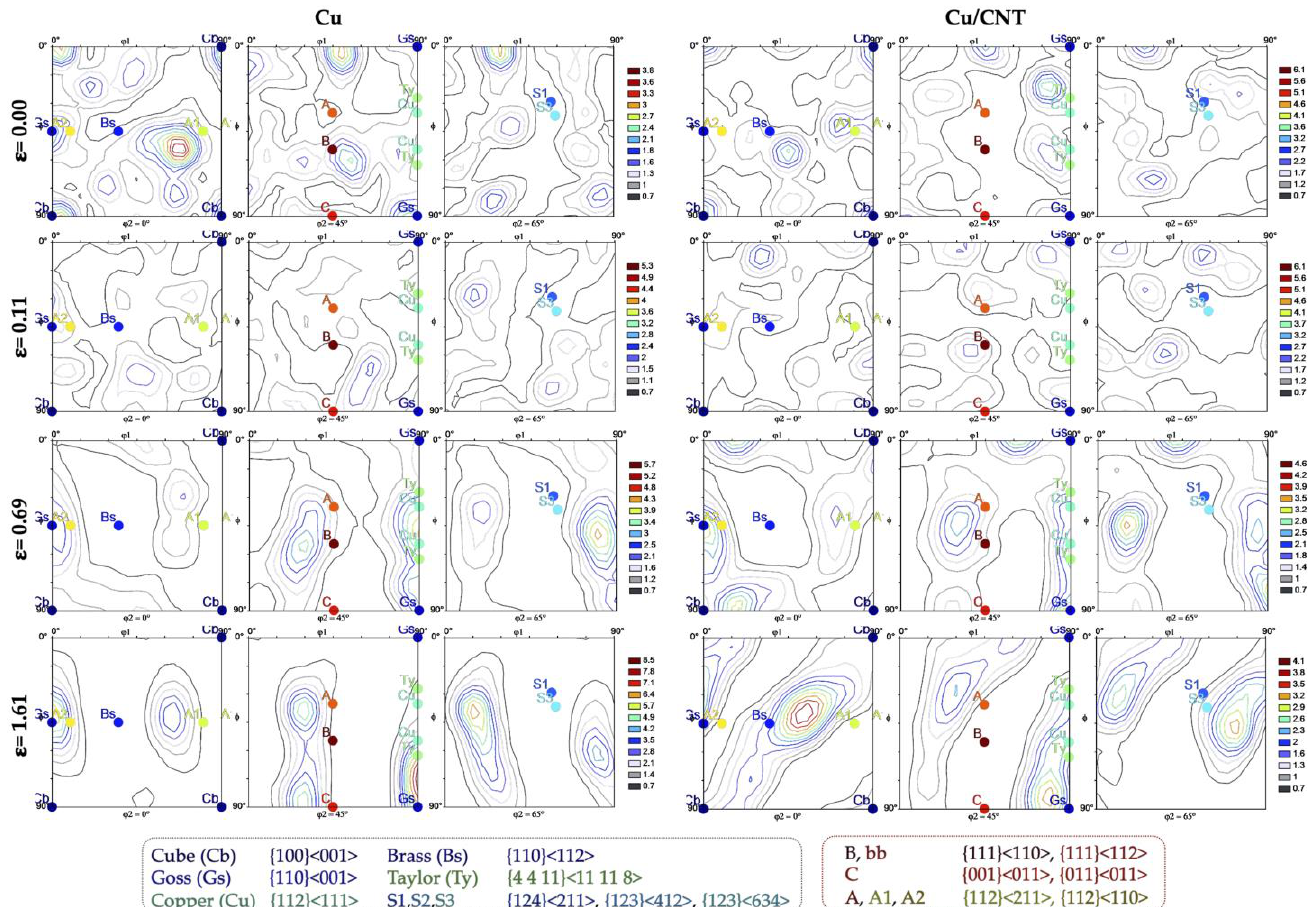
Figure 15. ODFs of Cu and Cu/CNT samples, as-sintered and after cold rolling to strains of 0.11, 0.69 and 1.61, respectively. In these ODFs, the main possible texture components are marked.